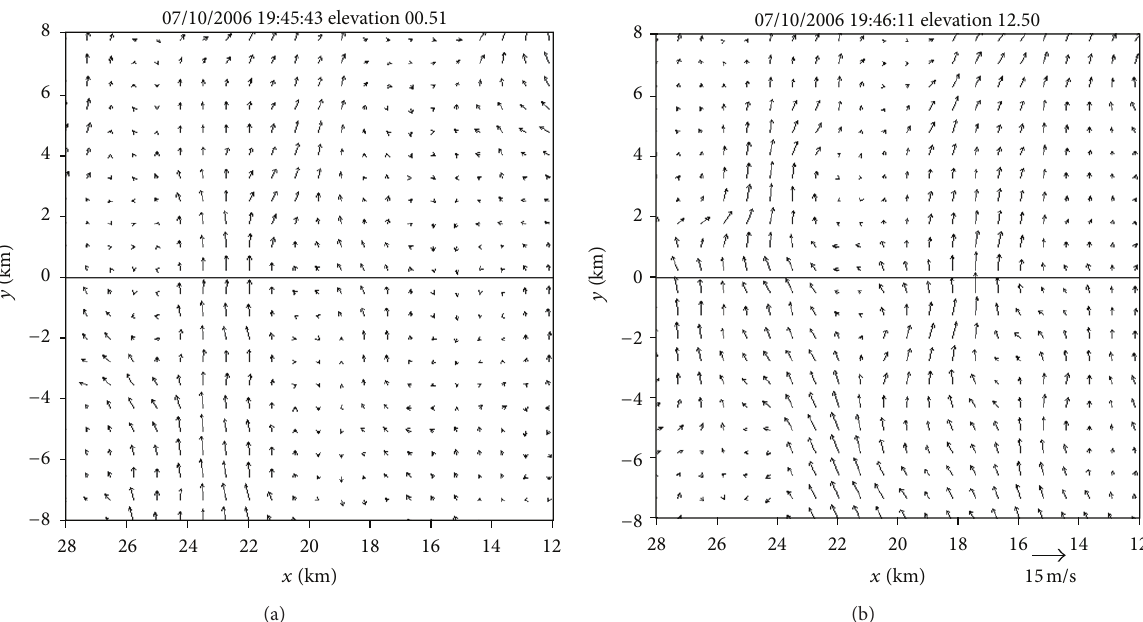
Figure 9: The difference fields obtained by subtracting the (𝑢 𝑚 , V 𝑚 ) fields in Figures 4(a) and 4(e) from those in Figures 8(a) and 8(b),